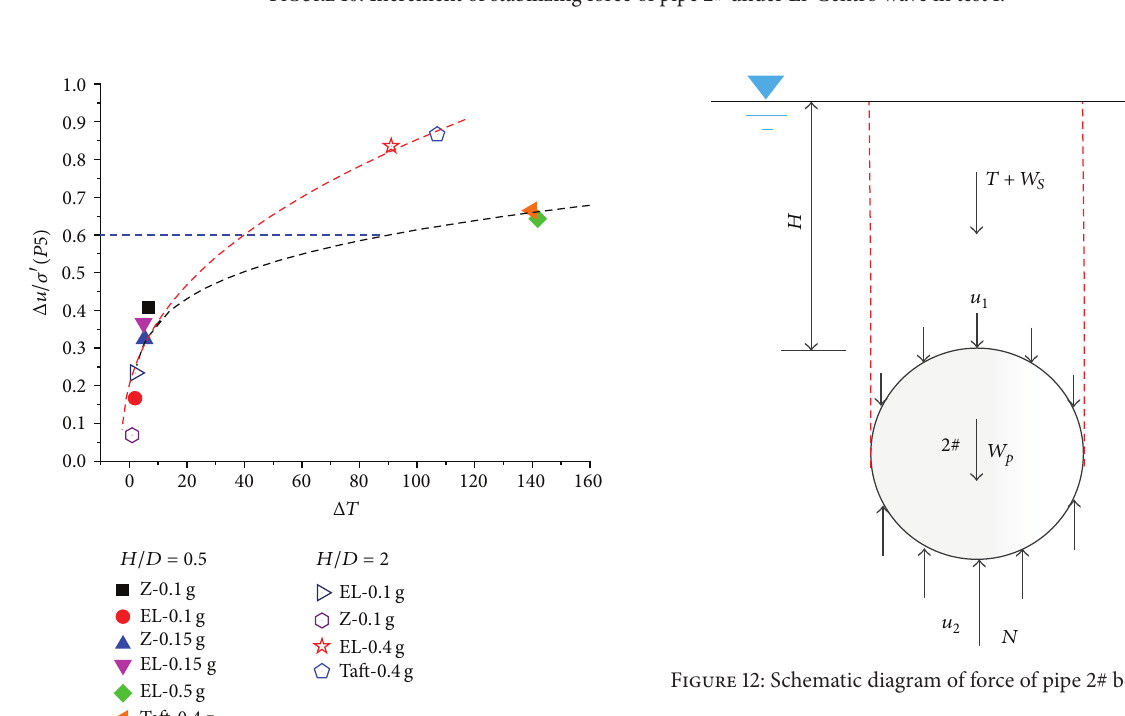
Figure 10: Increment of stabilizing force of pipe 2# under El-Centro wave in test 1.